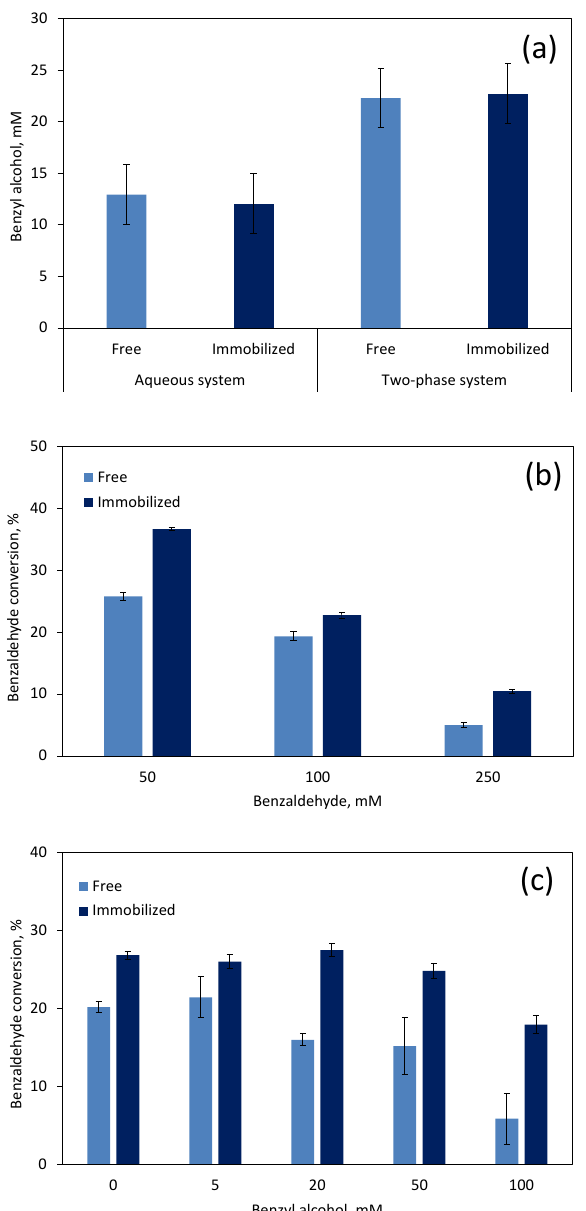
Figure 4. Effect of G. arilaitensis 232 cell immobilization on benzaldehyde conversion. ( a ) Comparison between the aqueous and the two-phase systems. ( b ) Effect of the initial benzaldehyde concentration on benzaldehyde conversion in the two-phase system. ( c ) Effect of benzyl alcohol concentration on benzaldehyde conversion in the two-phase system. Results are the average of three independent bioconversions. Data are presented as mean ± standard deviation.